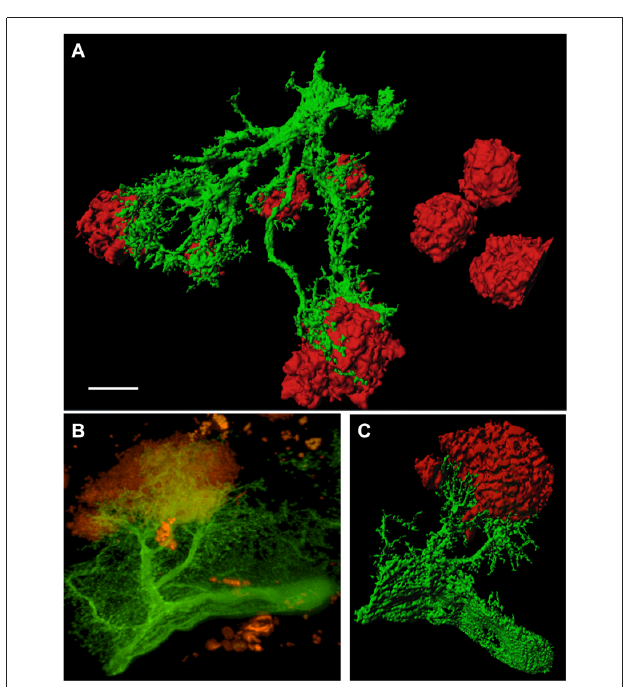
FIGURE 2 | GFP + astrocytes extend towards beta-amyloid (A βββ ) plaques in 12 month old APP-SweDI × GFP-GFAP mice. 3D-imaging reveals the tight association of reactive astrocytes (green) with A β plaques (red; A,C ). Thick astrocytic branches extend towards A β plaques and fine processes showed intense arborization (B) . Scale bar = 5 µ m (A) , 7 µ m (B,C)